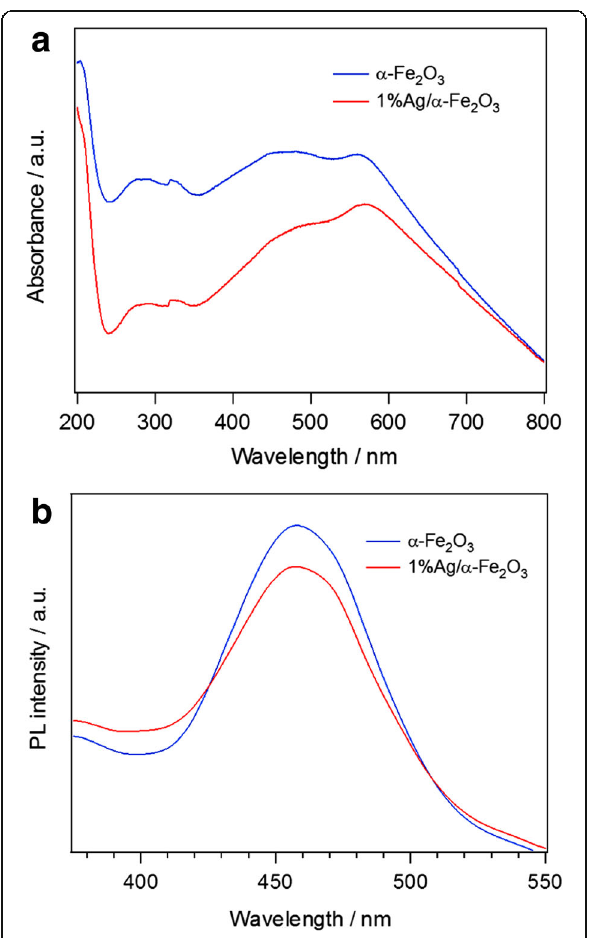
Fig. 3 a UV-vis optical absorption spectra measured in DI water and b PL spectra measured at an excitation wavelength 315 nm for α − Fe α − Fe 2 O 3 and 1%Ag/ 2 O